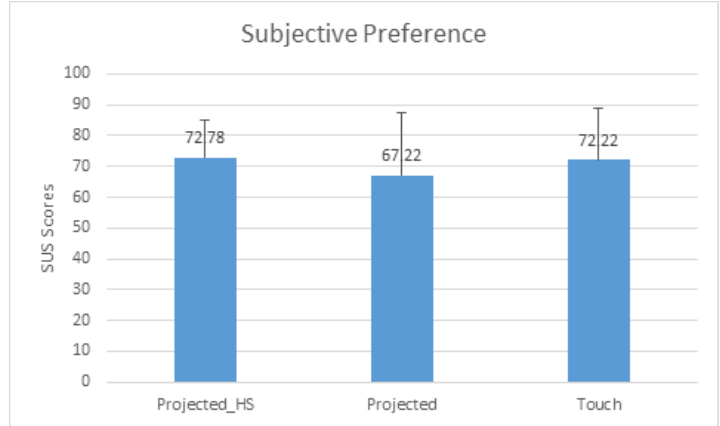
Figure 31. Comparing preference in terms of average SUS scores.